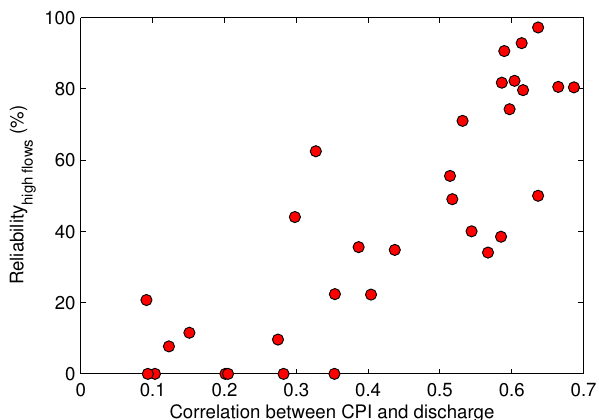
Figure 11. High-flow reliability for the local calibration with re- gional EPs plotted against the correlation coefficient between the Current Precipitation Index (CPI, Eq. 1) and observed discharge for intermediate and high flows. Basins without behavioural sim- ulations were assigned a reliability of